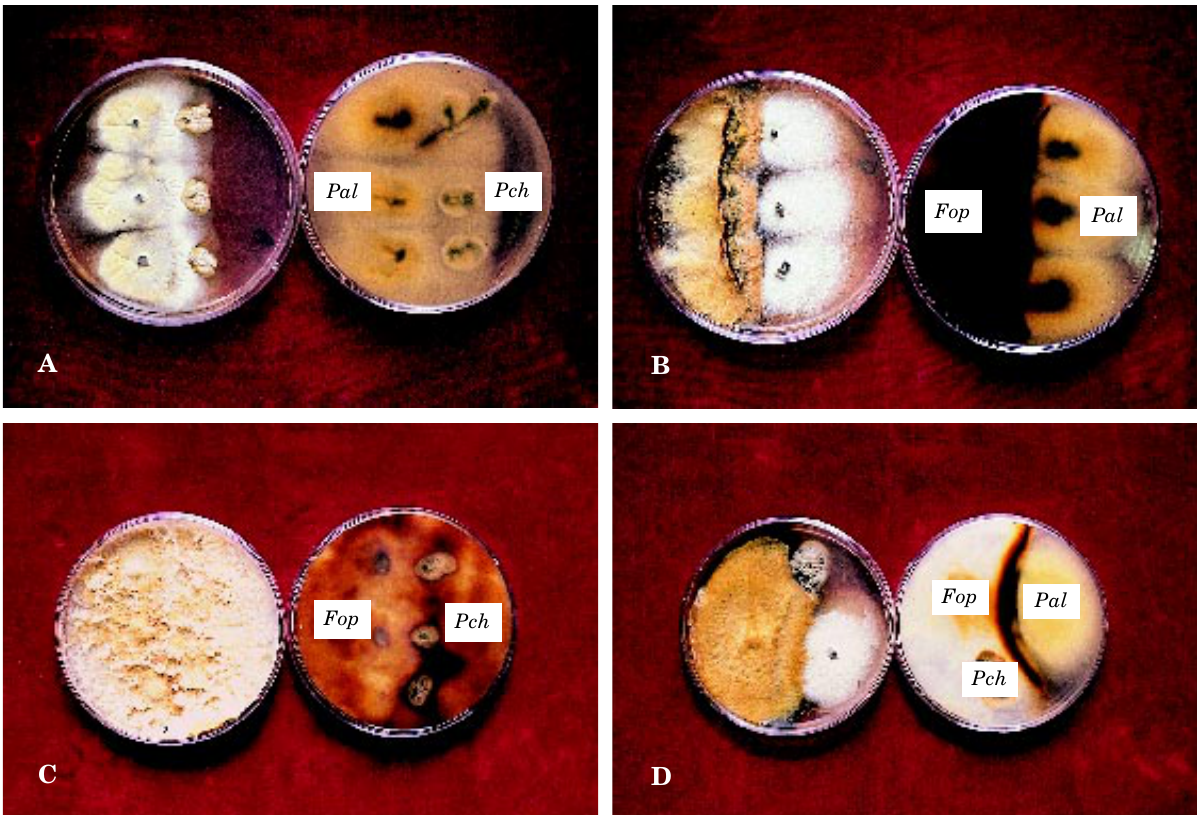
Fig. 3. Plates of 21 to 28-day-old dual cultures (on the left, obverse; on the right, reverse) of: A. Phaeoacremonium aleophilum ( Pal ) vs. P. chlamydosporum ( Pch ). B. Fomitiporia punctata ( Fop ) vs. Pal . C. Fop vs. Pch. When all three fungi were grown together (D), the antagonistic effect of Pal vs. Fop protected P. chlamydosporum , enabling it to grow as an individual colony without being overgrown by F. punctata . In this figure the reverse of the plate (on the right) is